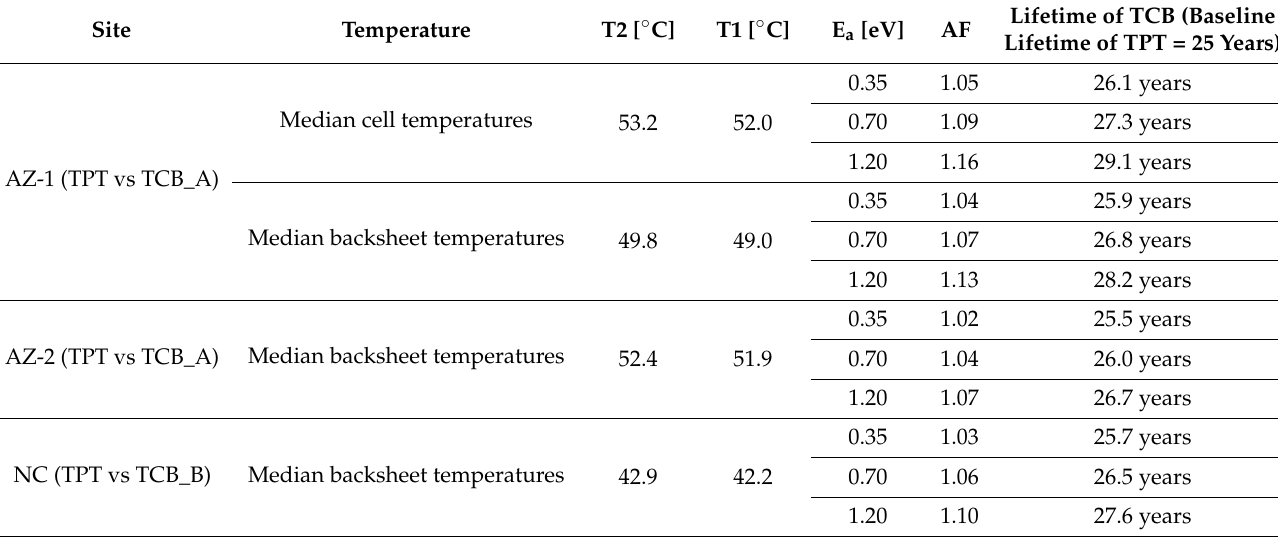
Table 4. Acceleration factor (AF) and lifetime for TCBs vs TPTs based on three E a values and on the median cell temperature of TPT versus TCB_A for AZ-1 site, on the median backsheet temperature of TPT versus TCB_A for AZ-2 site and on the median backsheet temperature of TPT versus TCB_B for the NC